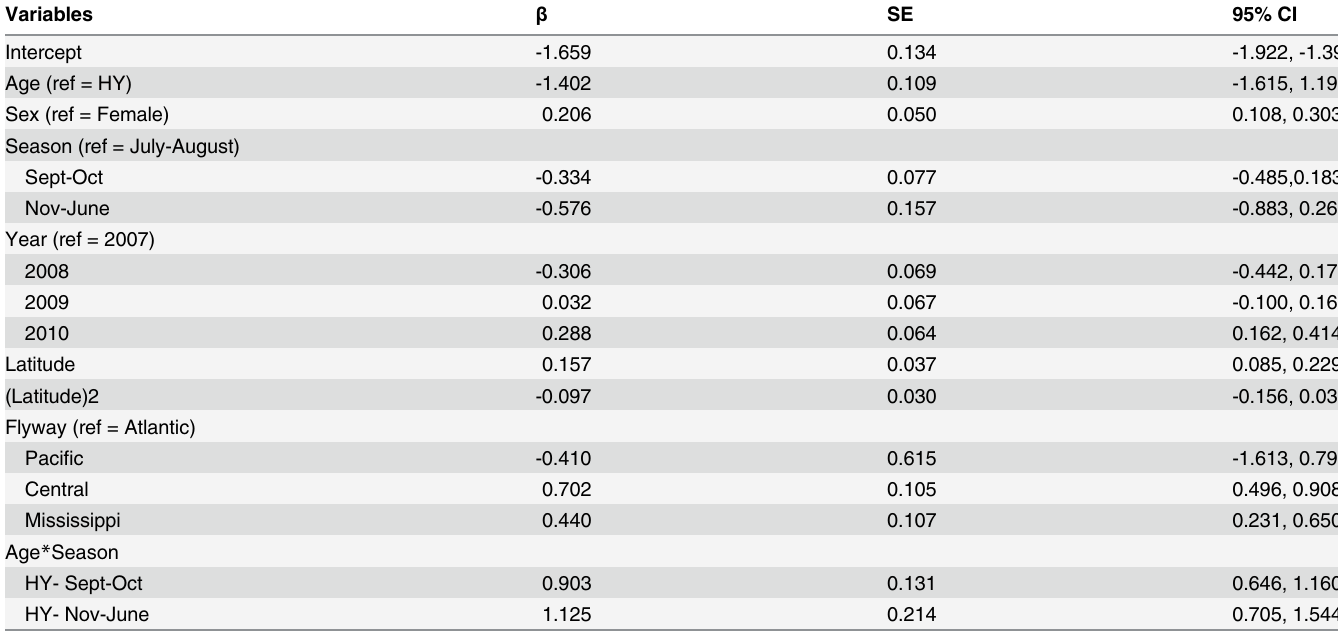
Table 3. Best-supported logistic regression model fitted to explain variation in AIV infection probability in Blue-winged Teal in Canada and the US, 2007 – 2010 (n = 13,574). Variables